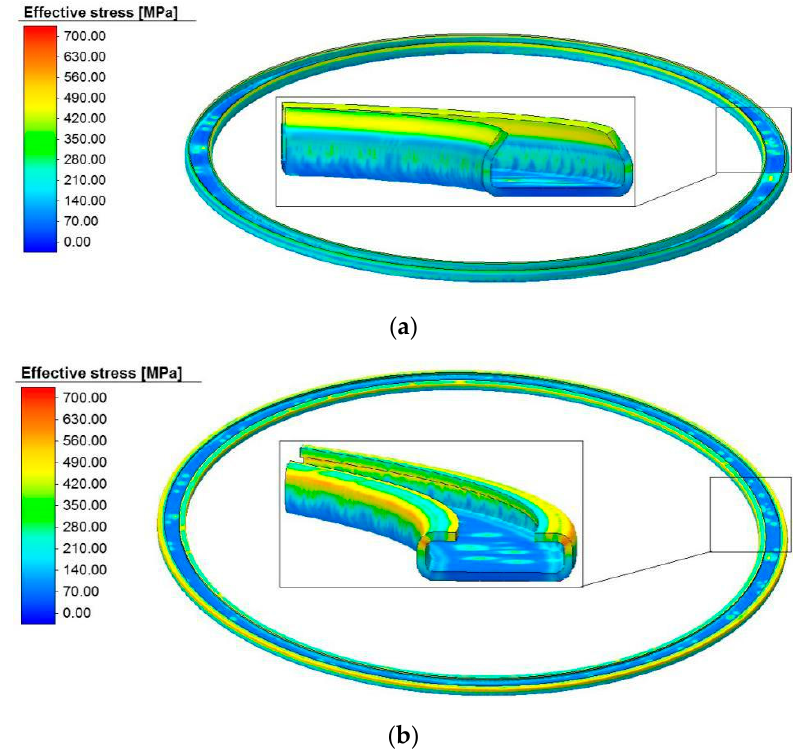
Figure 8. Stress field. ( a ) First pass; ( b ) second pass.